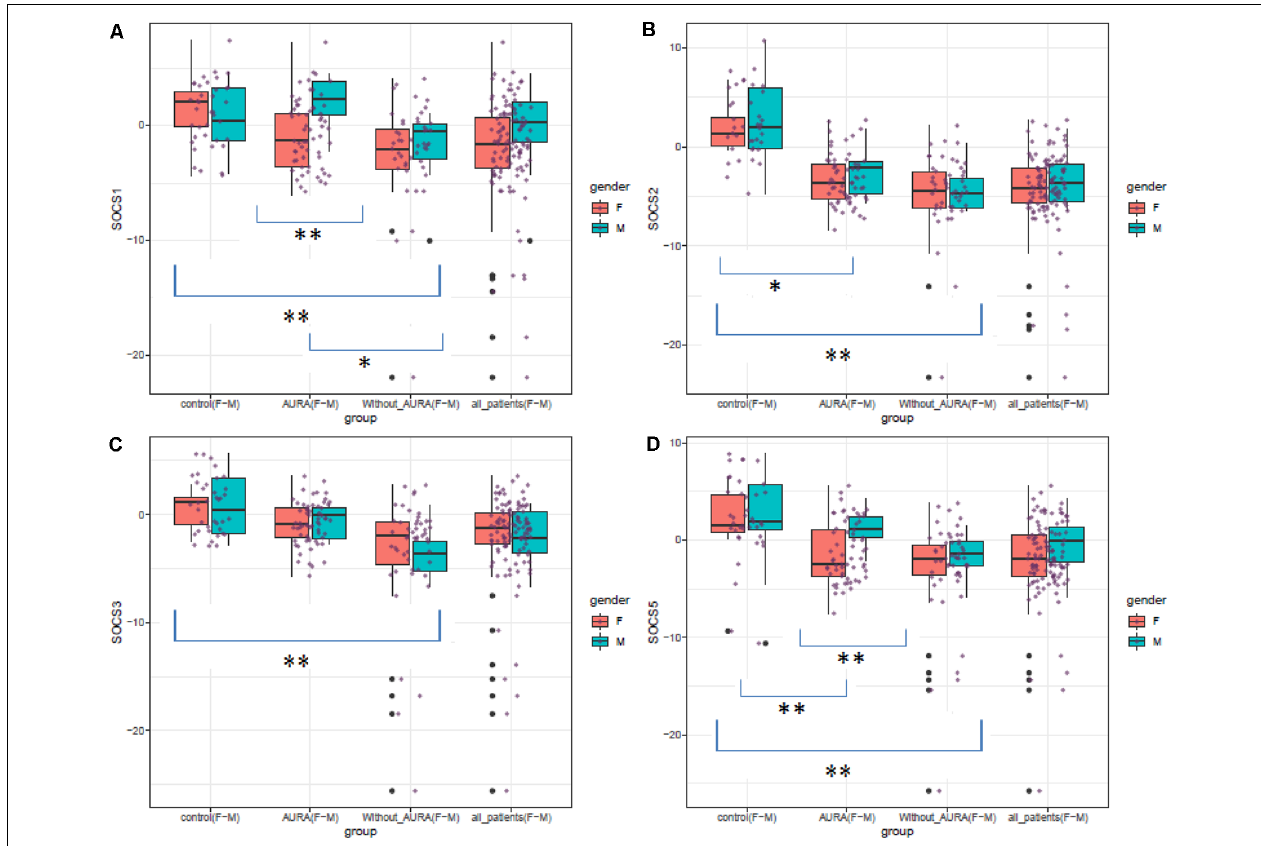
FIGURE 1 | Expression levels of SOCS genes in patients (total patients, patients with aura, and patients without aura) and controls based on their gender (Median and interquartile range are shown. Purple points show each expression level. Outliers are also shown by black points. ∗ P value < 0.05, ∗∗ P value < 0.001).